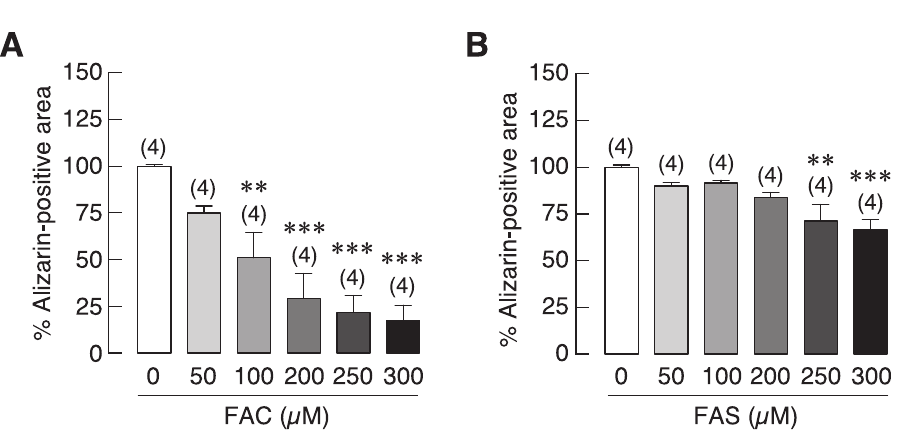
Fig 2. Quantified data from alizarin red S staining depicting calcium deposition of UMR-106 cells under iron overload with (A) FAC and (B) FAS. Both FAC and FAS significantly decreased osteoblast calcium deposition. �� P < 0.01, ��� P < 0.001 as compared to control group (0 μ M).